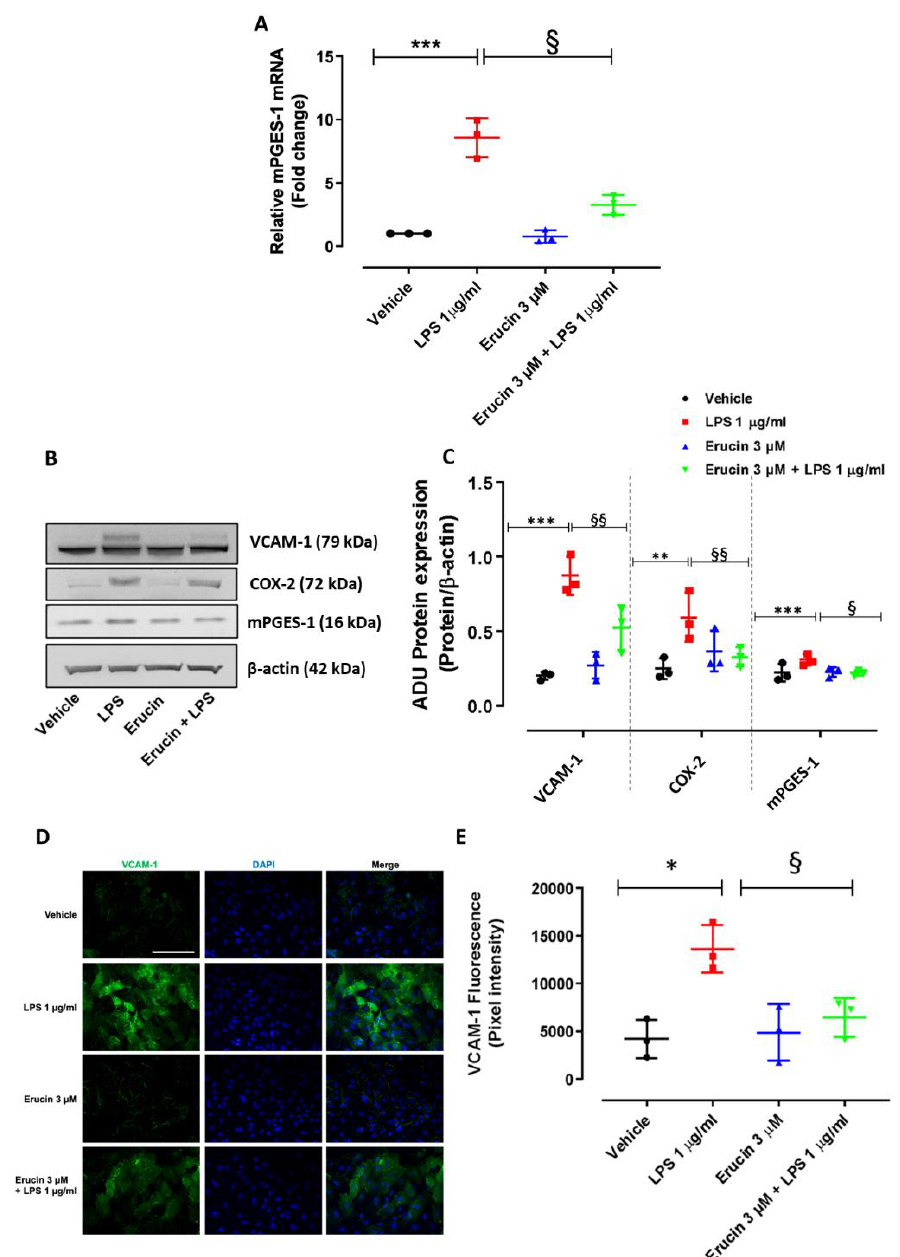
Figure 5. Effects of erucin on inflammatory markers and enzymes in endothelial cells treated with LPS. ( A ) mPGES-1 gene expression evaluated by RT-PCR. ( B ) Western blot analysis of inflammatory markers: VCAM-1, COX-2 and mPGES-1. Each lane contains 50 µg of total proteins obtained from endothelial cells pre-treated with erucin (3 µM, 1 h) and then exposed to LPS (1 µg/mL, 6 h). Blots are representative of three different experiments. ( C ) Quantification of the optical density of each protein of interest respect to its β -actin (n = 33). ( D ) VCAM-1 localization in HUVECs evaluated by immunofluorescence. Cells were pre-treated with erucin (3 µM, 1 h) and then with LPS (1 µg/mL, 6 h). Images were obtained by confocal microscope. Scale bar — 50 µm. ( E ) VCAM-1 fluorescence intensity was measured on four images per slide by using Fiji software. Results are shown as mean ± SD. * p <0.05, ** p < 0.01 and *** p < 0.001 vs. vehicle; § p < 0.05 and §§ p < 0.01 vs. LPS 1 µg/mL.